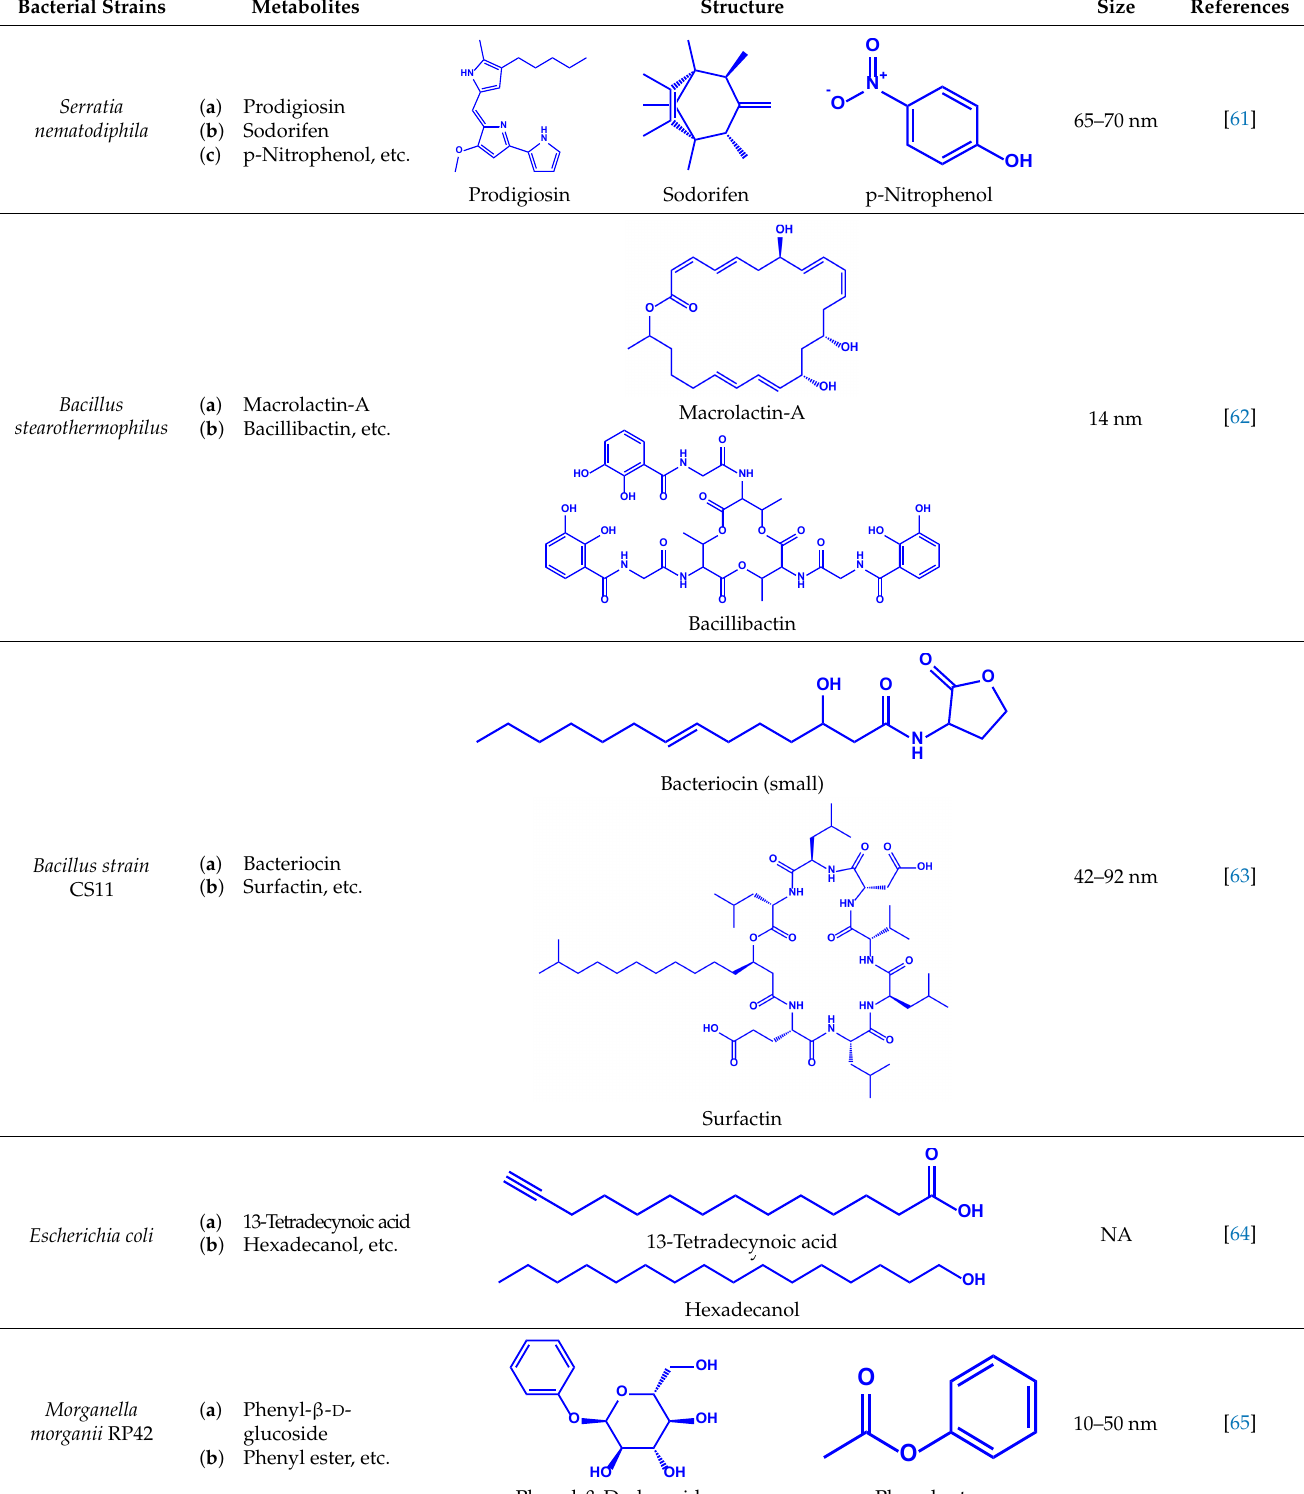
Table 2. Biological synthesis of AgNPs by various bacterial strains.